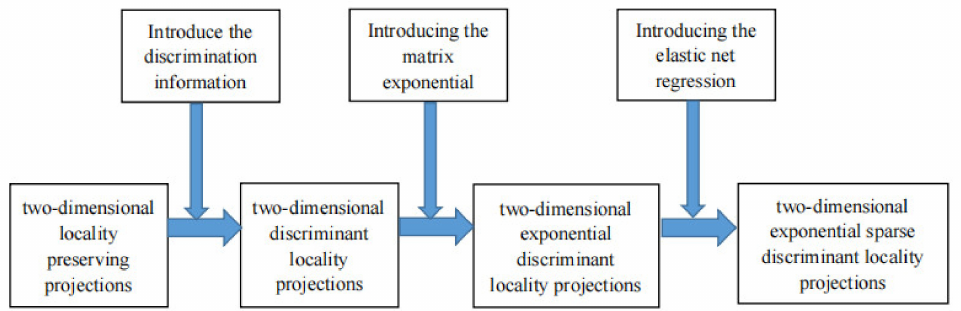
Figure 1. The development route of the 2DESDLPP